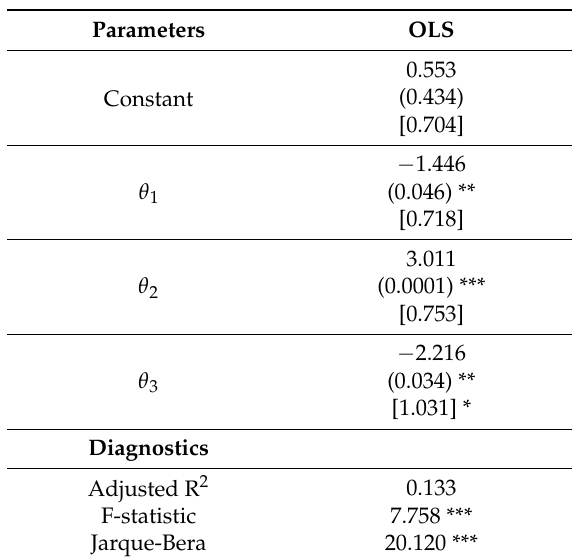
Table 3. OLS estimates of TFCI for April 2005–June